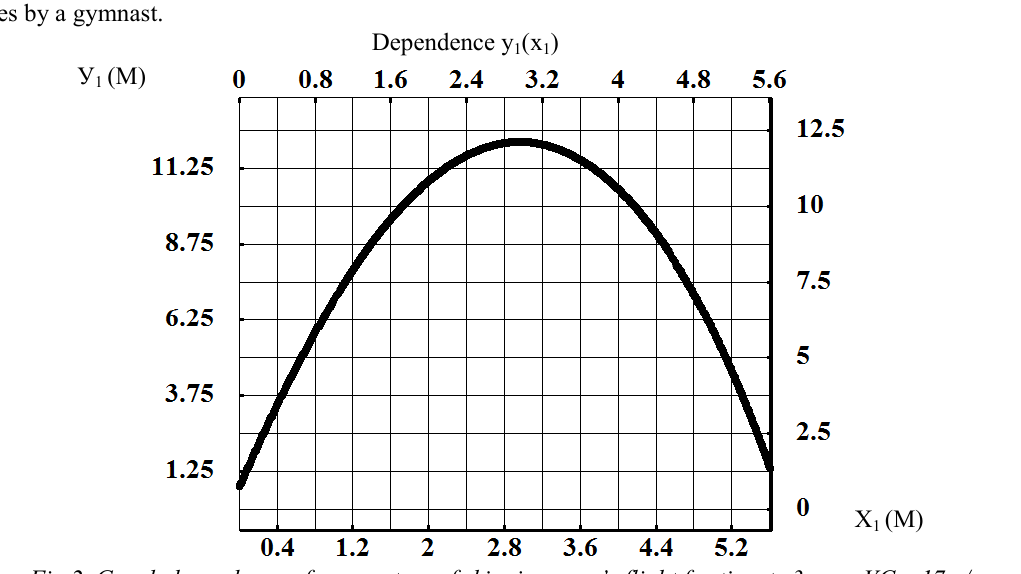
Fig.2. Graph dependence of parameters of skipping rope’s flight for time t=3sec.; VС 0 =17m/sec; α C0 =82 0 ; h Cо =0.7m.; m=